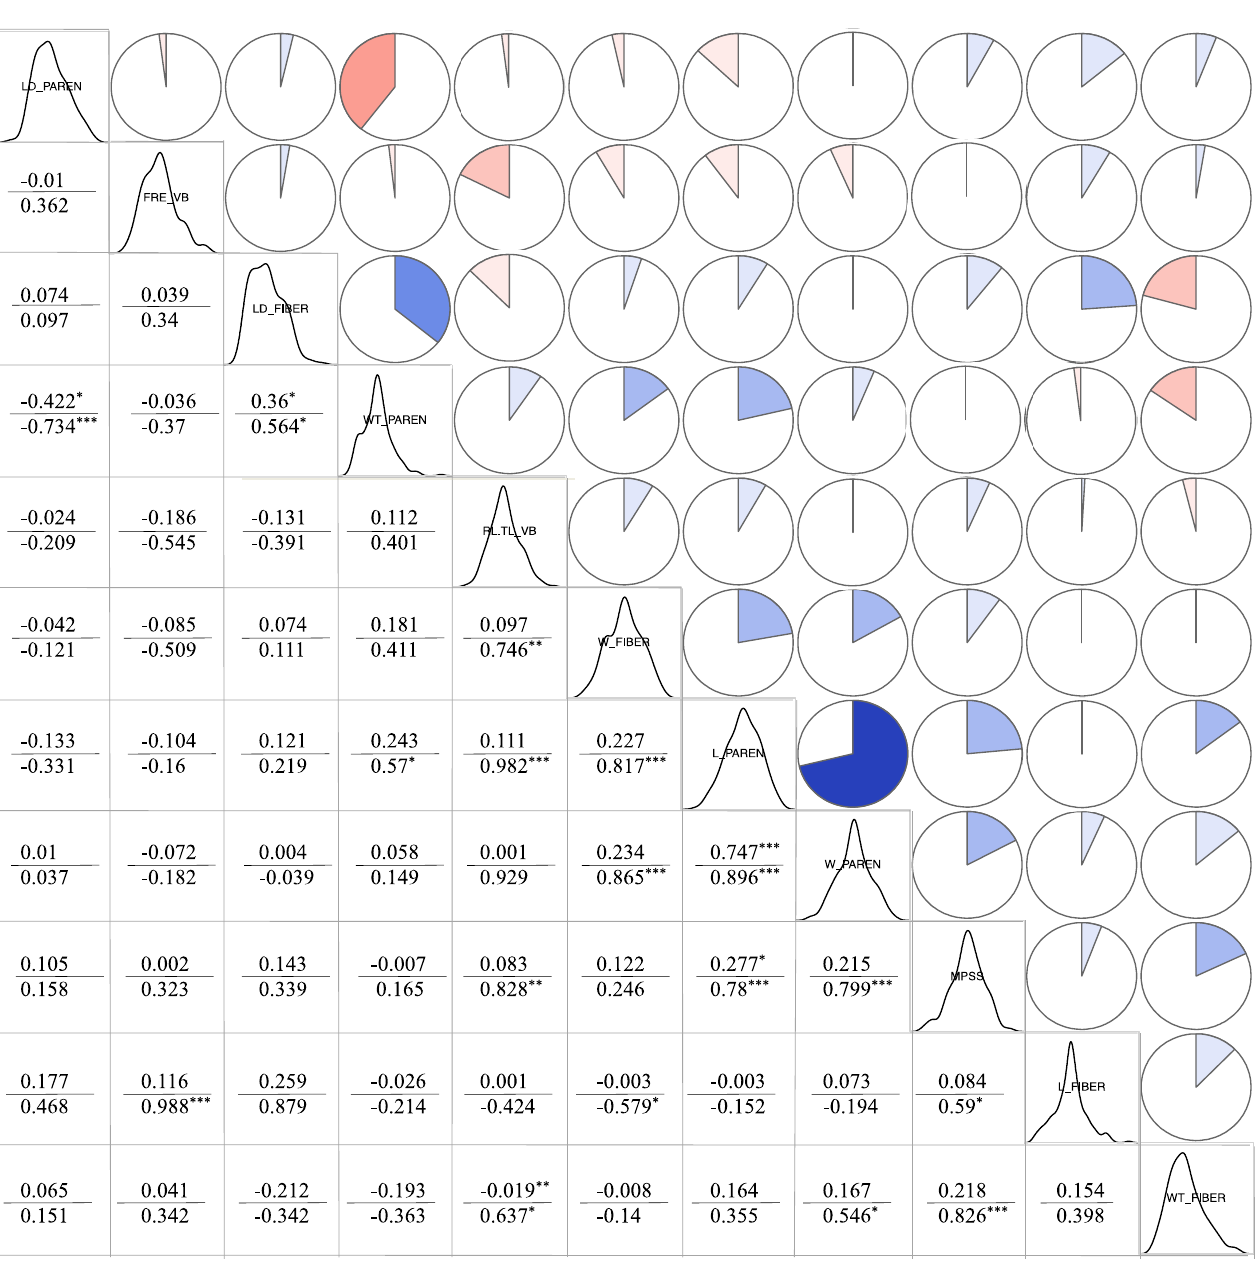
Figure 4. Correlation analysis of 11 cell structure properties in Moso bamboo ( Phyllostachys edulis ).